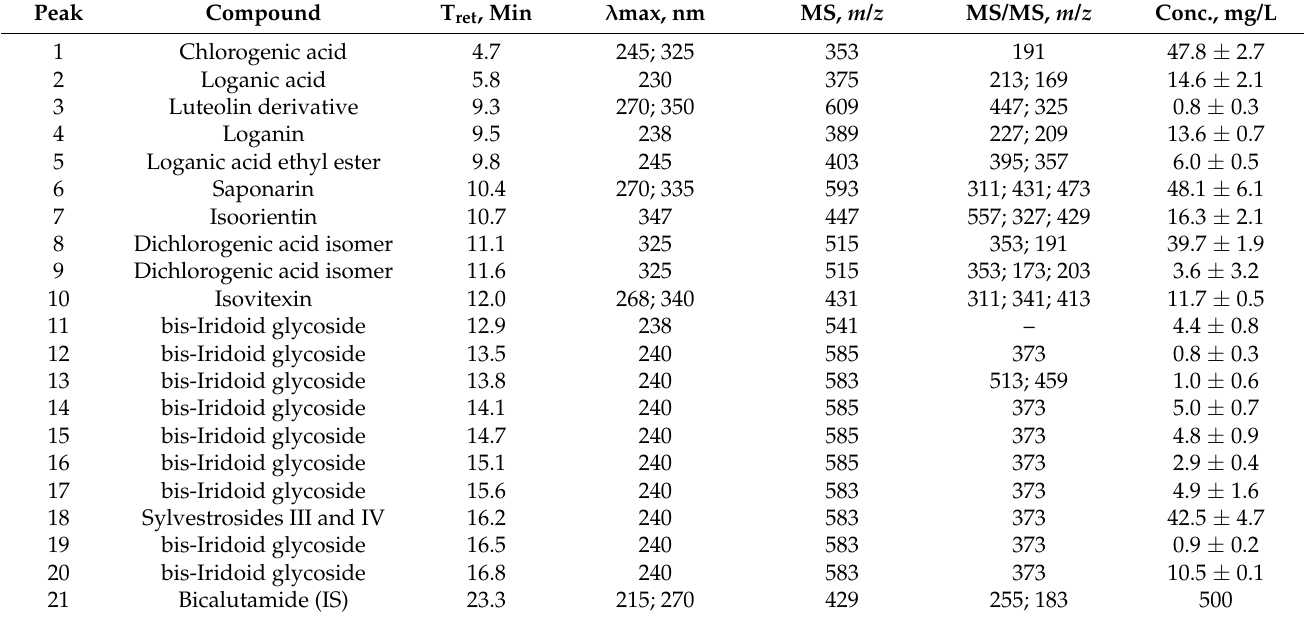
Table 1. Identification and concentrations of DE compounds.